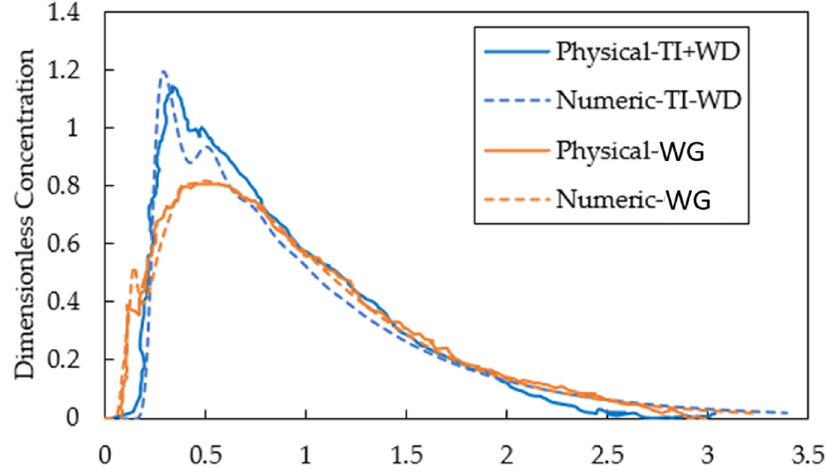
Figure 10. RTD curves of physical modeling and numerical modeling results in single-phase case TI + WD and multiphase case